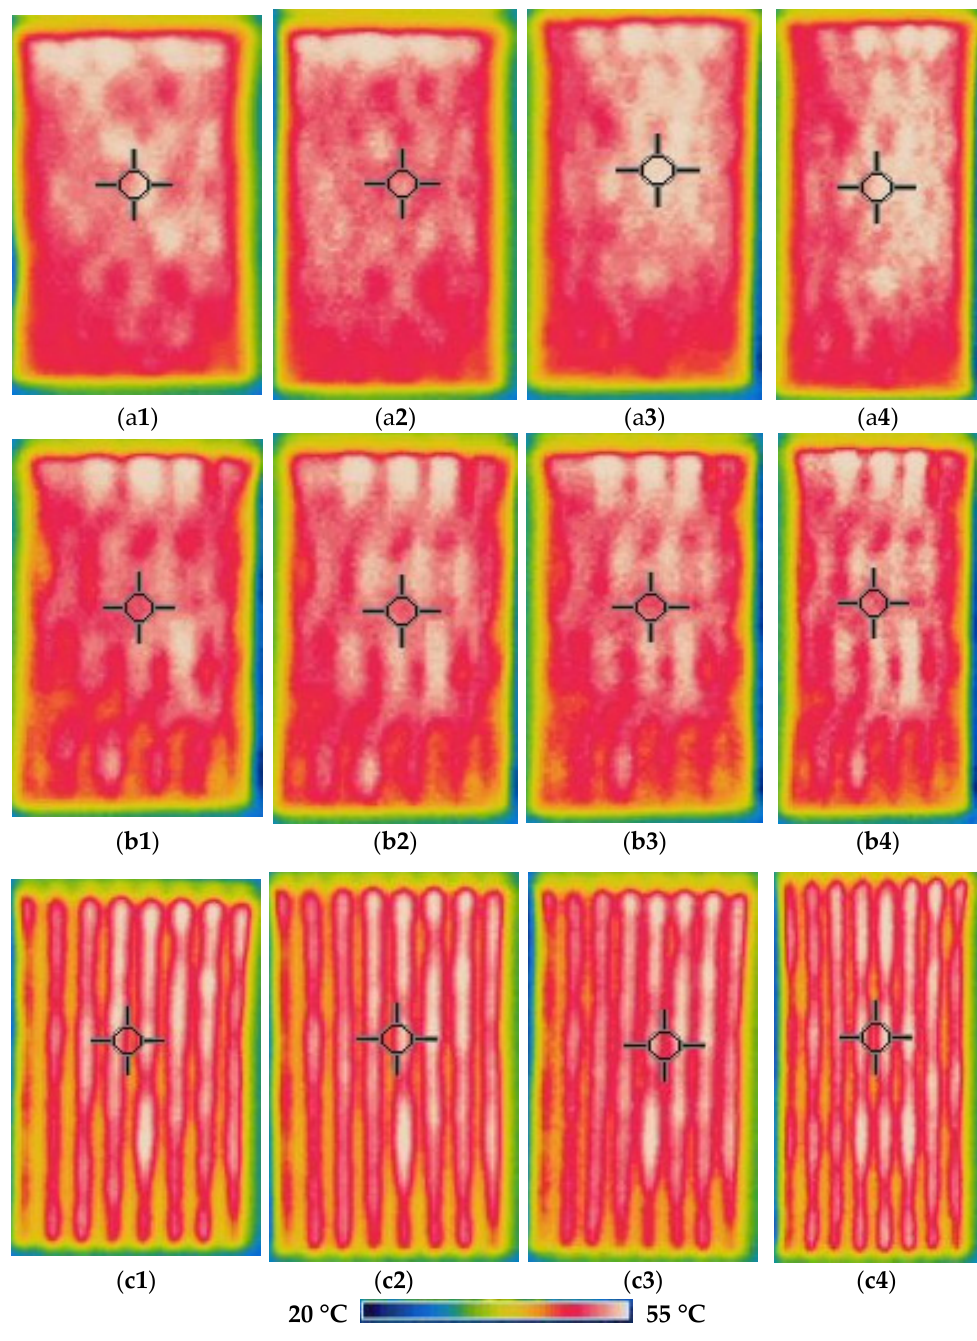
Figure 8. Thermal images of electro-conductive fabrics of CF_HY group after 600 s of 1.5 V application: infrared images at ( a1 ) non-stretched, ( a2 ) 10% stretched, ( a3 ) 15% stretched and ( a4 ) 20% stretched of CF_HY1 structured fabric; ( b1 ) non-stretched, ( b2 ) 10% stretched, ( b3 ) 15% stretched and ( b4 ) 20% stretched of CF_HY2 structured fabric; and ( c1 ) non-stretched, ( c2 ) 10% stretched, ( c3 ) 15% stretched and ( c4 ) 20% stretched of CF_HY3 structured fabric.